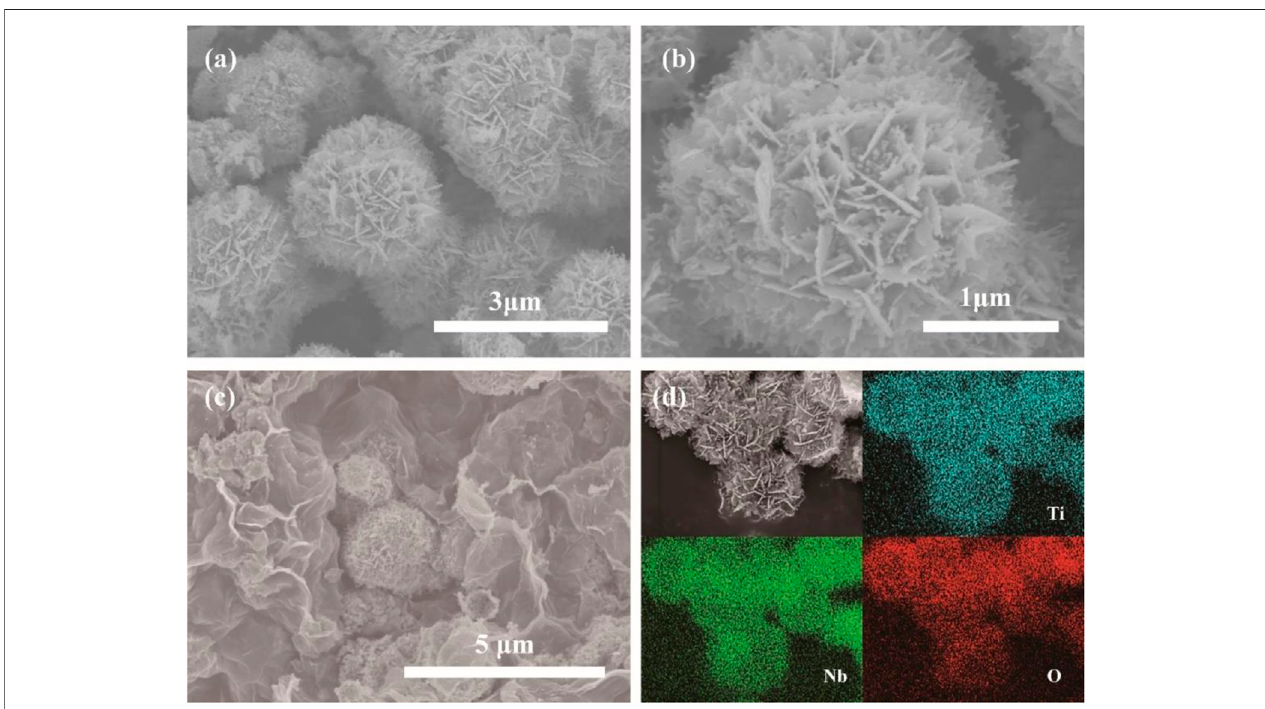
FIGURE 3 | (A) SEM image of pristine TNO, (B) enlarged magni fi cation SEM image of pristine TNO, (C) SEM image of TNO/NC/GO, (D) EDS mapping of different elements.